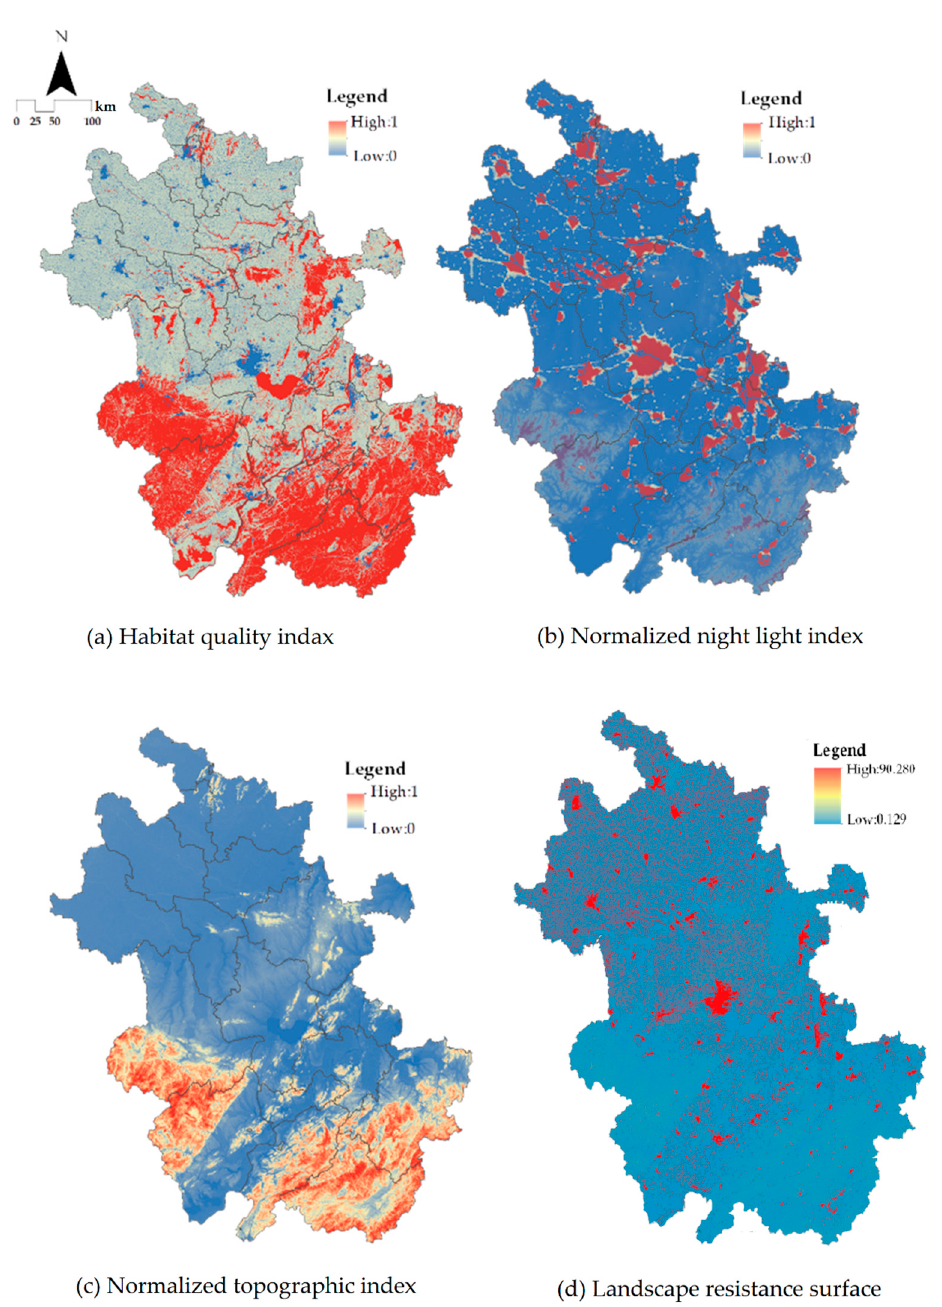
Figure 7. Spatial pattern of landscape resistance surface in Anhui Province.